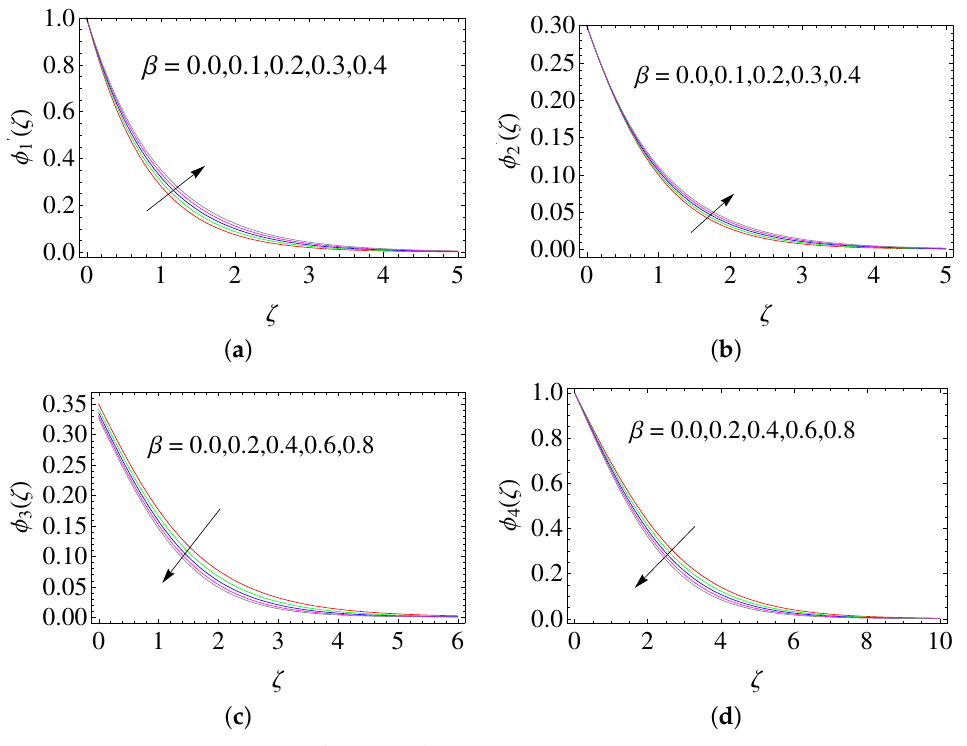
( ζ ) , ( b ) φ (cid:48) ( ζ ) , ( c ) φ ( ζ ) , and ( d ) φ ( ζ ) . 3 4 2 1 ( ζ ) , φ ( ζ ) , and φ ( ζ ) is analyzed 3 4 2 ( ζ ) enlarges while boosting c , whereas φ ( ζ ) and φ ( ζ ) 3 4 2